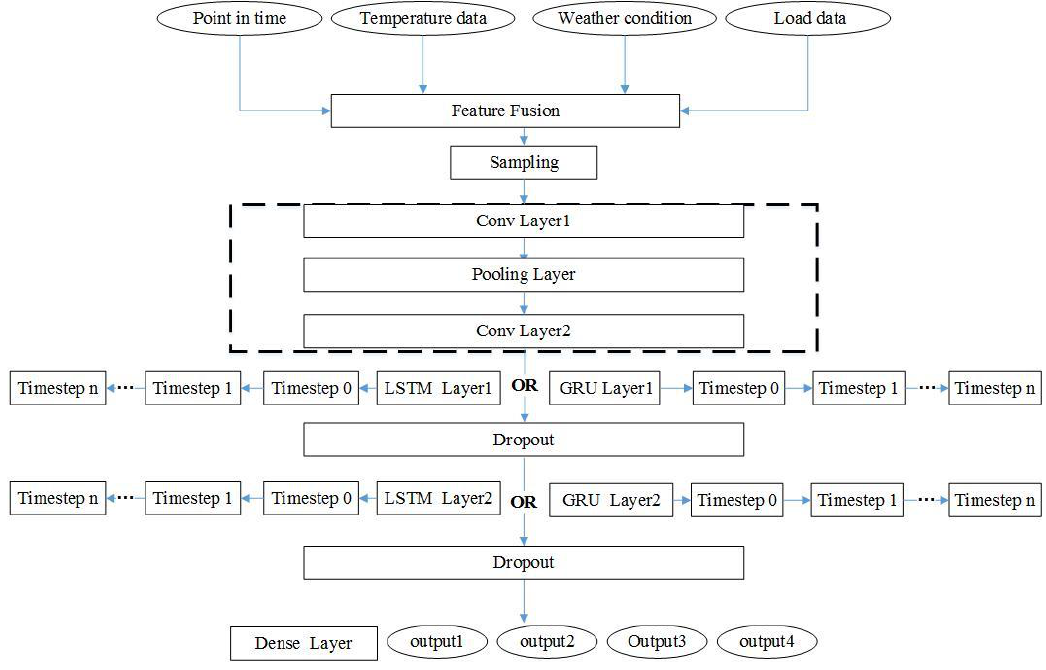
Figure 4. Deep learning framework.